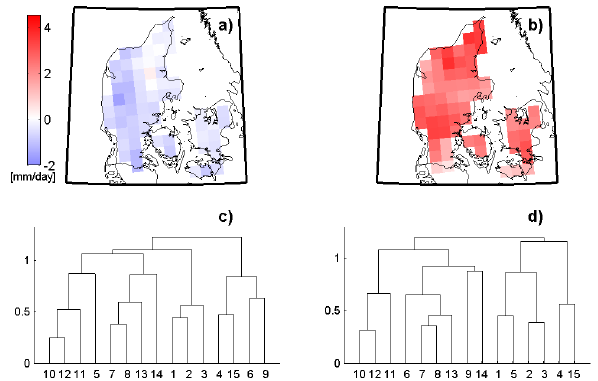
Fig. 8. Ensemble average error (a, b) and dendrograms (c, d) for Prec95p estimated using CGD-25 (a, c) and E-OBS (b, d) . The y axis in the dendrograms shows the dissimilarity of the climate mod- els. Model numbers are shown in Table